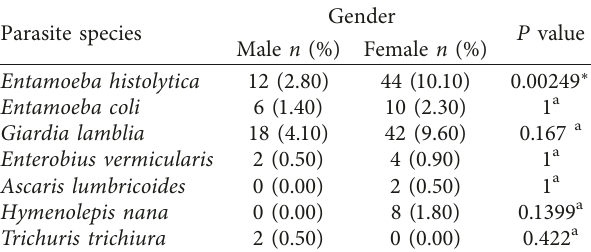
Figure 4: Distribution of the type of parasitism in the sample studied. Table 1: Summarizing the distribution of parasitic species among participants according to